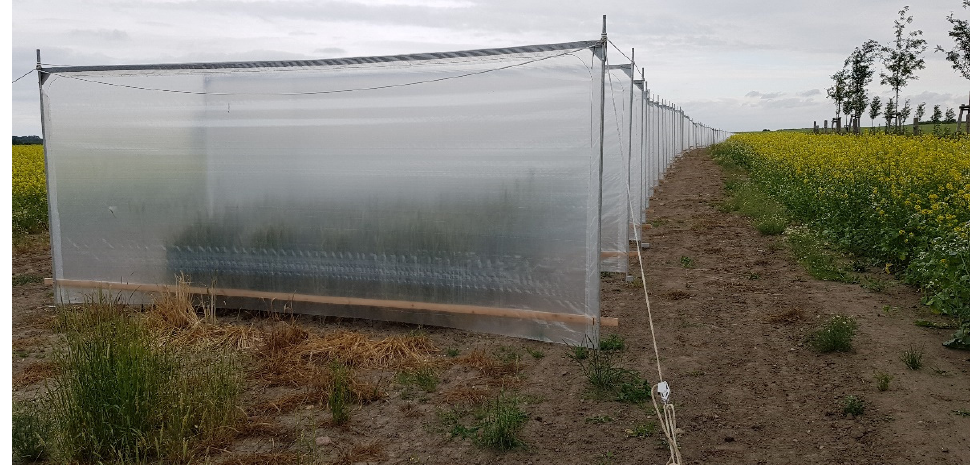
Figure 4. Production of experimental P-type CMS hybrids between foliar isolation walls.